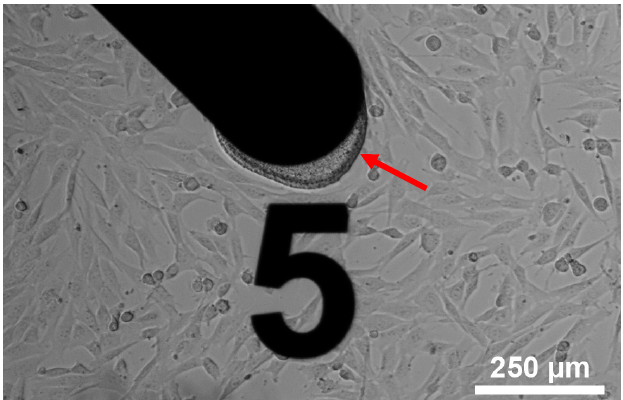
Figure 3. NIH-3T3 cells cultivated on the sensor chip surface. The arrow indicates the pHEMA based hydrogel on the working electrode.